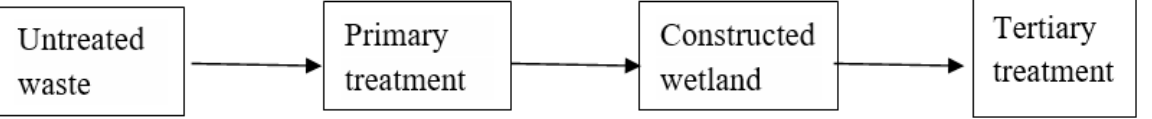
Figure 1. Constructed wetlands in a standard sewage treatment system .